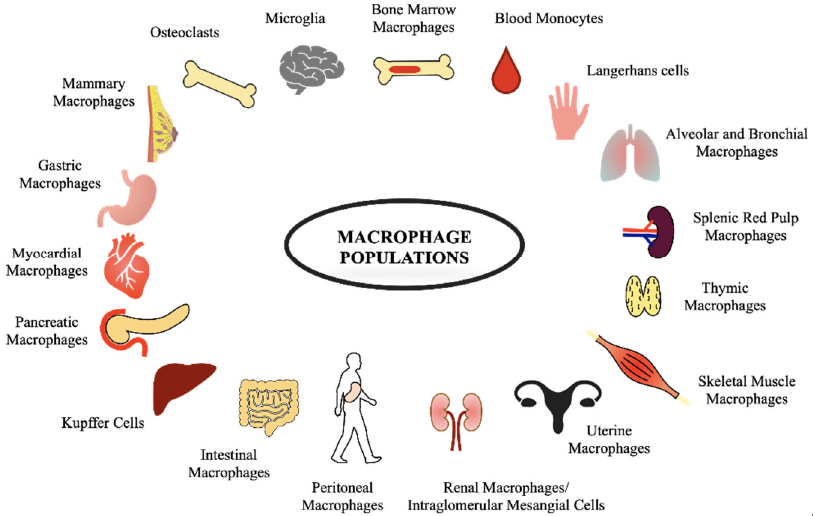
Figure 1. Examples of different macrophage populations associated with different tissues are